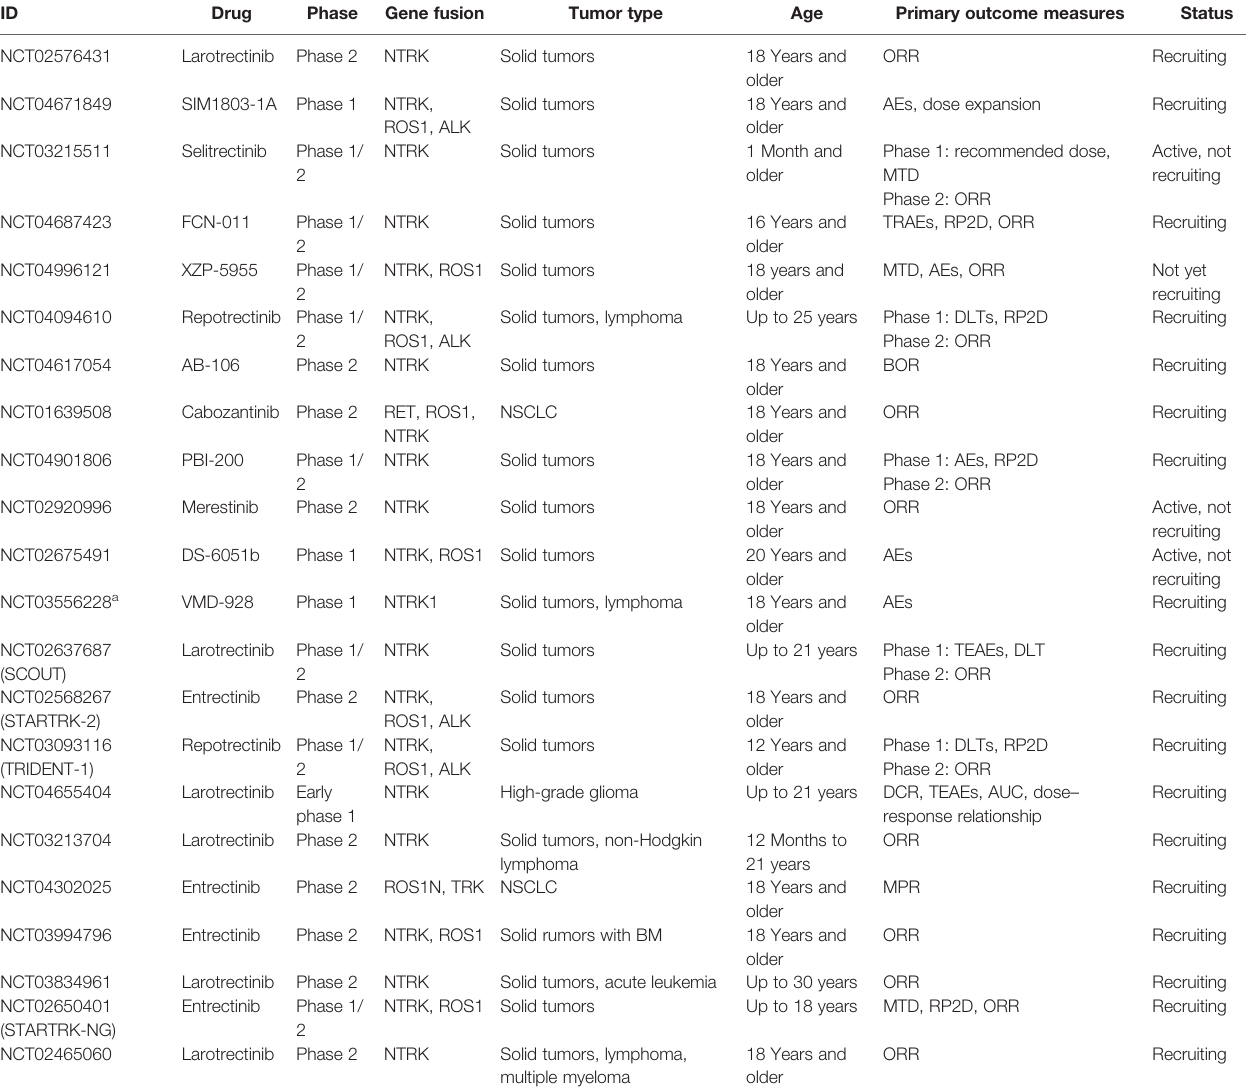
TABLE 2 | Ongoing clinical trials for NTRK fusion-positive